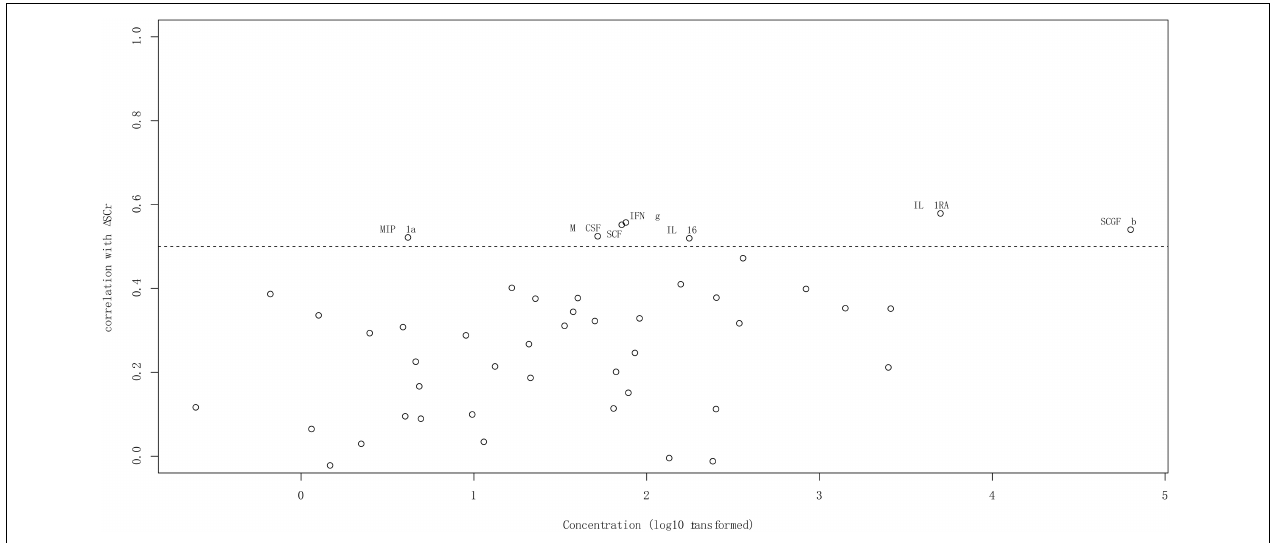
FIGURE 3 | The correlation coefficients of the plasma concentrations of these 48 cytokines with the postoperative (cid:49) SCr.